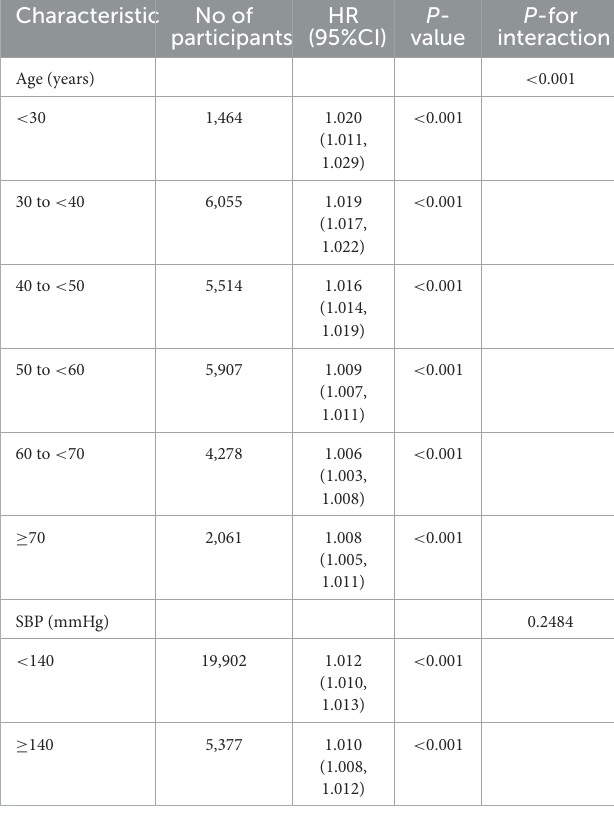
TABLE 7 Stratified associations between TyG-BMI and diabetes in participants with prediabetes by age and SBP. Characteristic